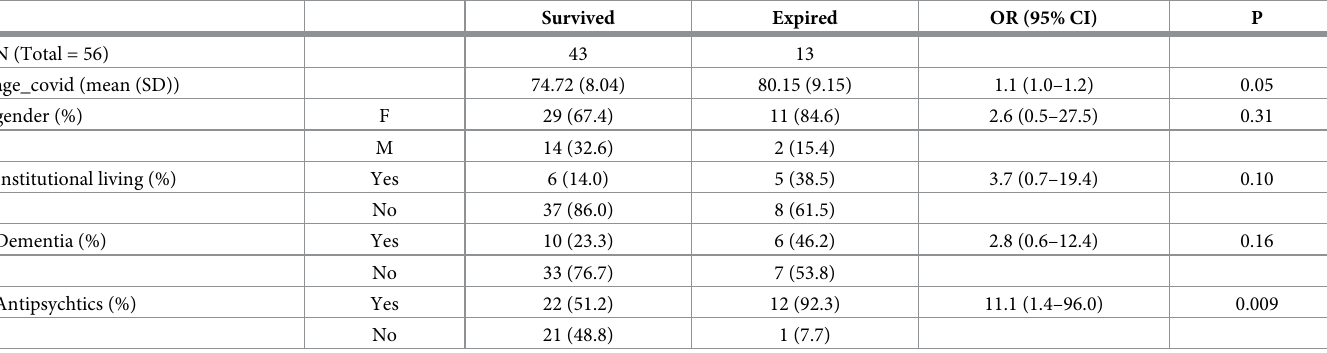
Table 1. Patient characteristics stratified by outcome of COVID-19 patients.